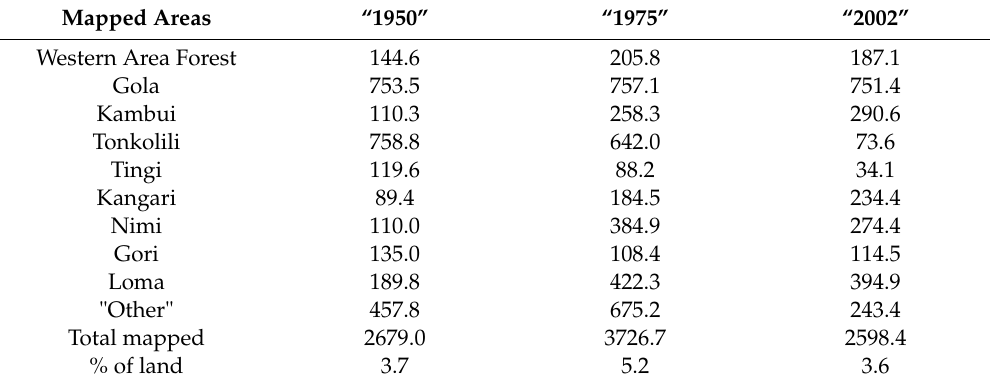
Table 1. Mapped Areas (in sq km) of the larger forest fragments shown on the three maps.